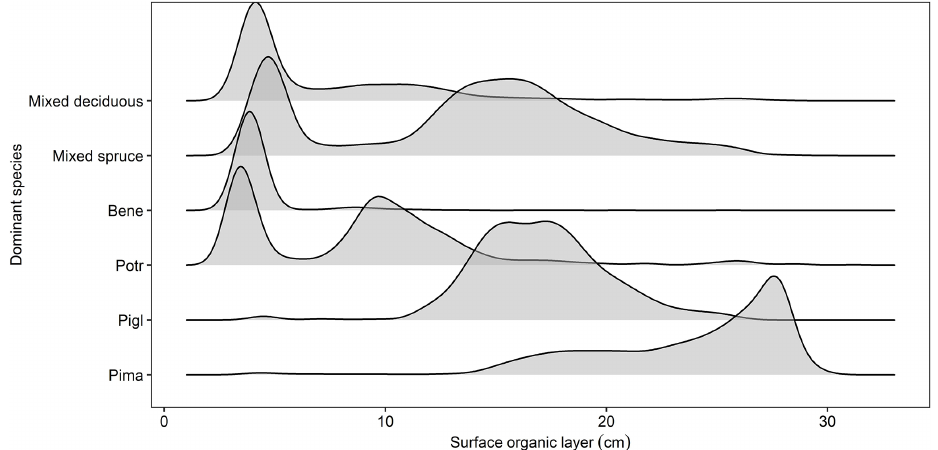
Figure B2. Simulated surface organic layer depth as a function of dominant forest type in a 61000ha forested landscape in interior Alaska. Model output is from simulation year